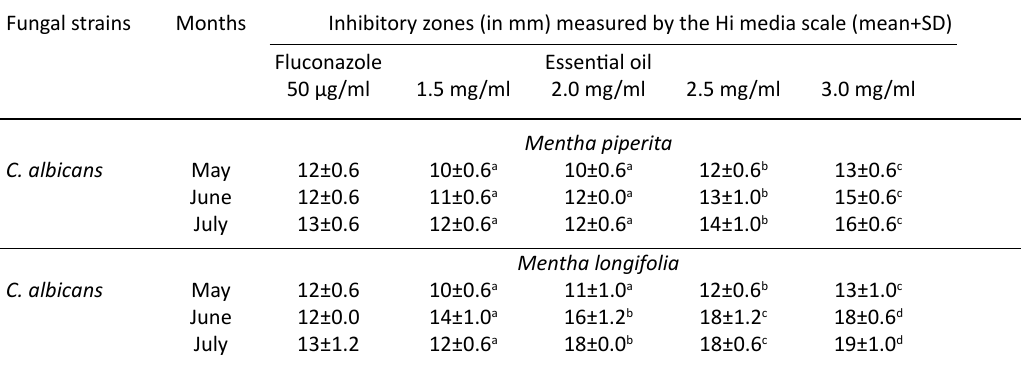
Table 5. Antifungal activity of essential oil of leaves of M. piperita and M. longifolia against C. albicans Fungal strains